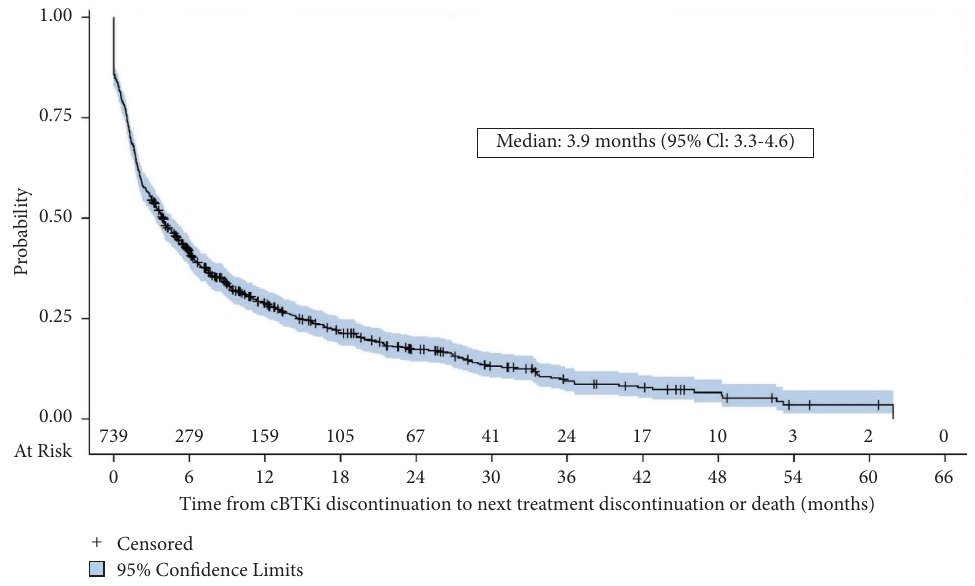
Figure 4: Time to next treatment discontinuation or death ( n � 739). Abbreviations: cBTKi � covalent bruton tyrosine kinase inhibitor; CI � confdence